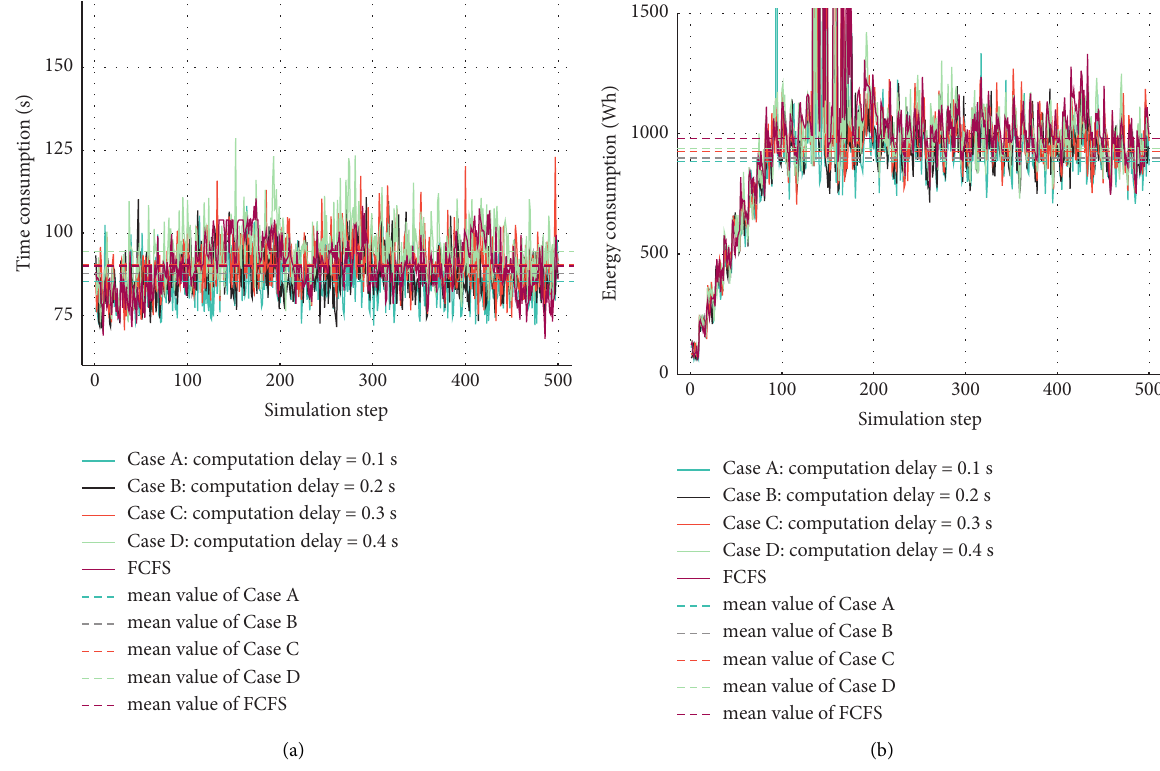
Figure 9: Comparison for values of objective function under different computation delays. (a) Time consumption and (b) electricity